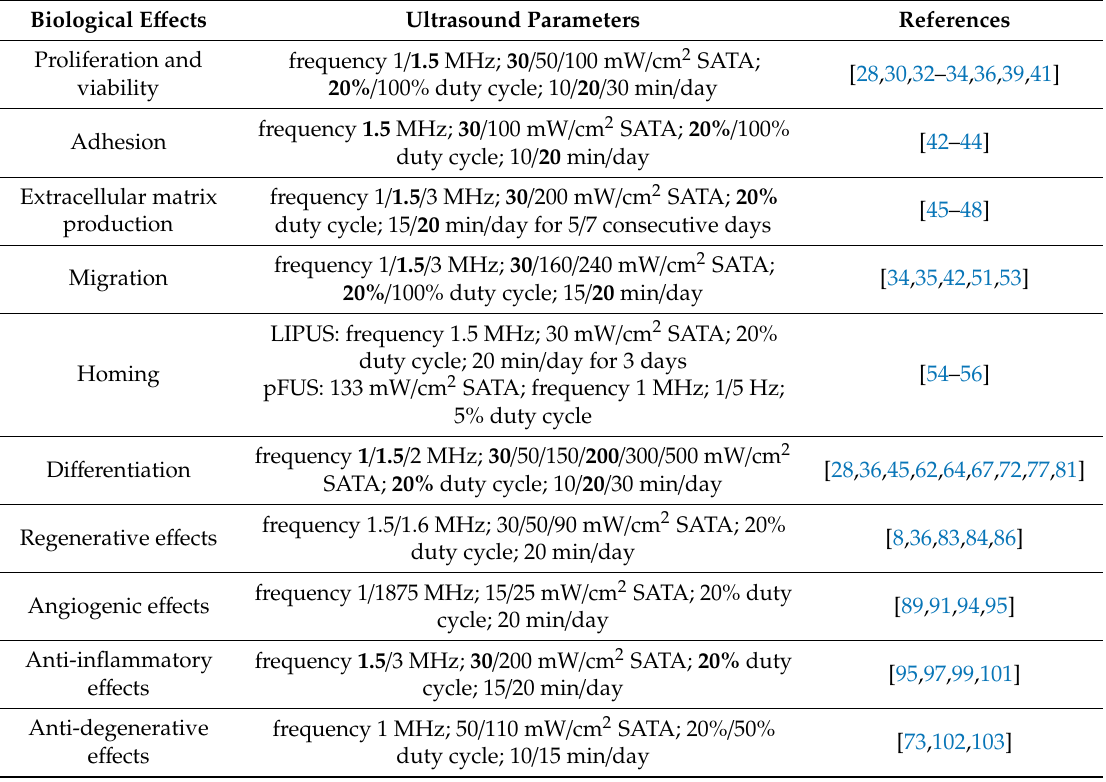
Table 2. More frequent ultrasound parameters used for regenerative e ff ects. The most common ones are highlighted in